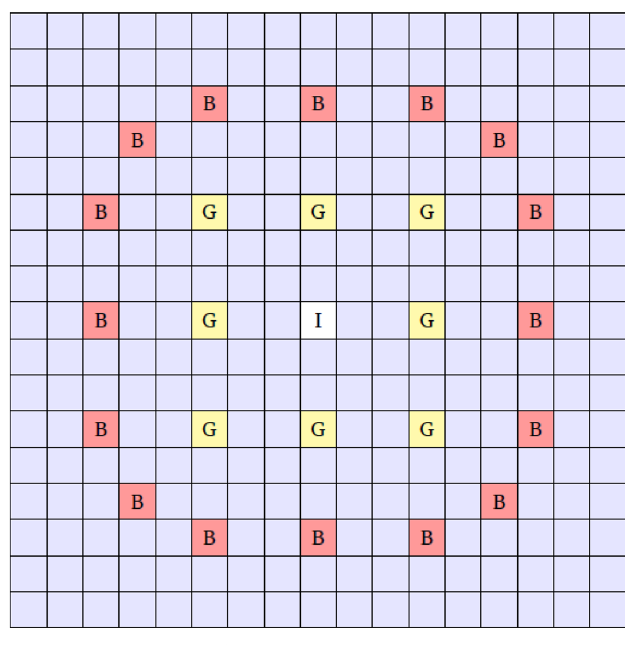
Fig. 4. Assembly with 16 pyrex